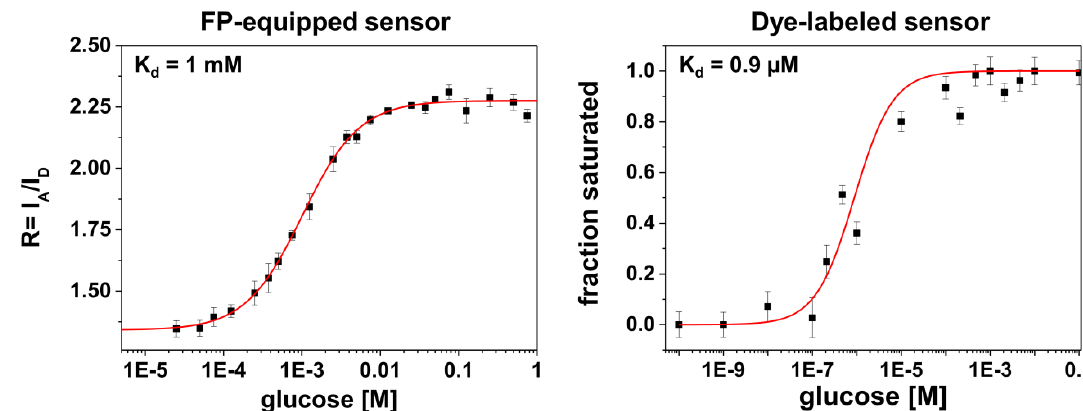
Figure 3. FRET parameter as a function of glucose concentration for the two kinds of MgIB-based sensors. For the FP-equipped constructs ensemble data were used (taken from [22]) to calculate a FRET ratio R = I A /I D (where I A and I D are the peak intensities of the acceptor and the donor emission, respectively) (left panel), while for the dye-labeled construct the smFRET statistical weights of the liganded population are reported (right panel).